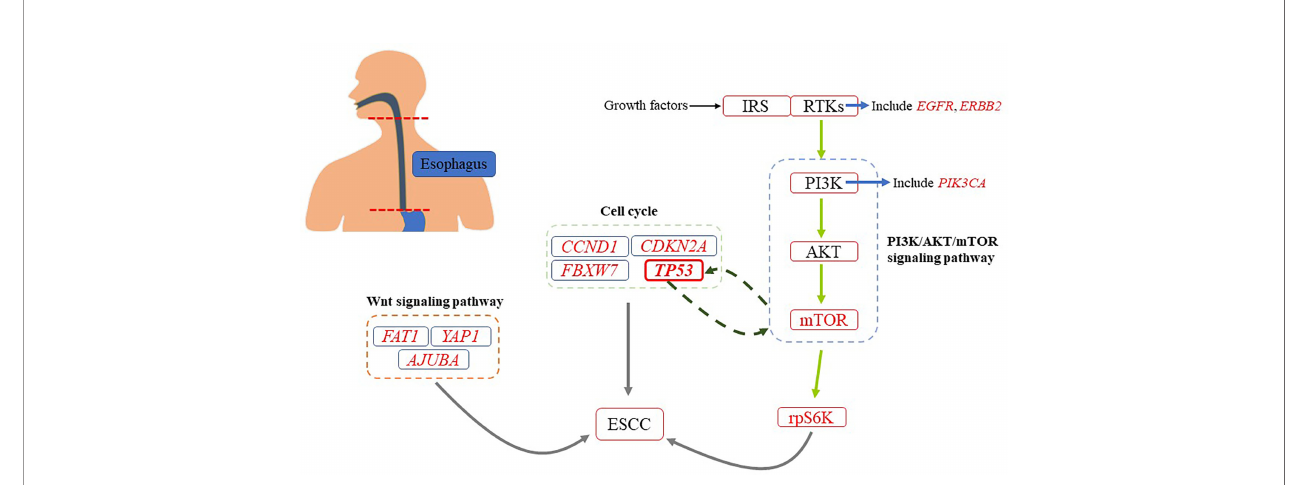
FIGURE 2 | A simpli fi ed diagram of genetic changes about ESCC. There are many genetic changes associated with ESCC. It has been found that PI3K/AKT/mTOR pathway is closely related to the occurrence and development of